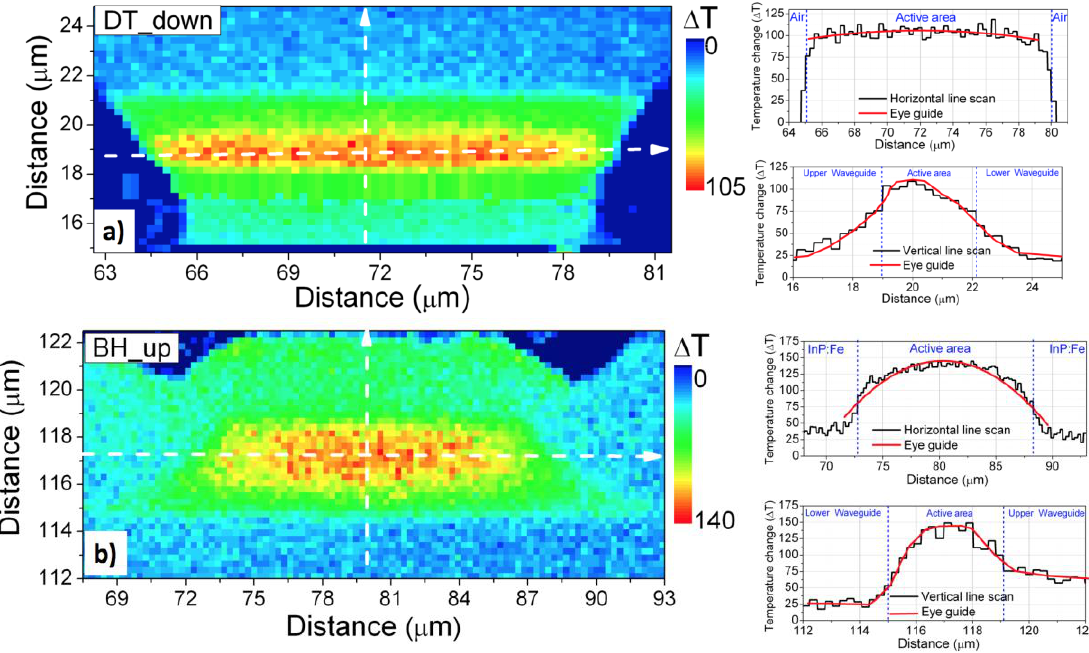
Figure 7. ( a ) Temperature distribution line scans across the laser facet, taken at the center of the active area perpendicular to the epitaxial layers and ( b ) maximum temperature increases as a function of current density for all investigated types of